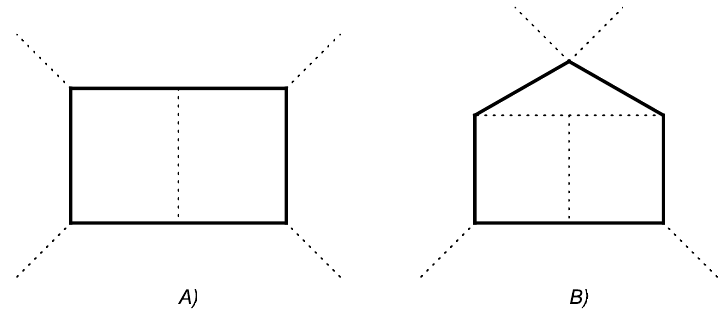
Figure 2 . Example of four point d = 4 dual conformal integrals in the Higgs regularisation (all regulator masses are equal) [30]. The solid lines correspond to the massive propagators and the dashed lines correspond to the massless ones. Integral A) has an equivalent in dimensional regularisation, integral B) is unique to the Higgs one - it is proportional to m